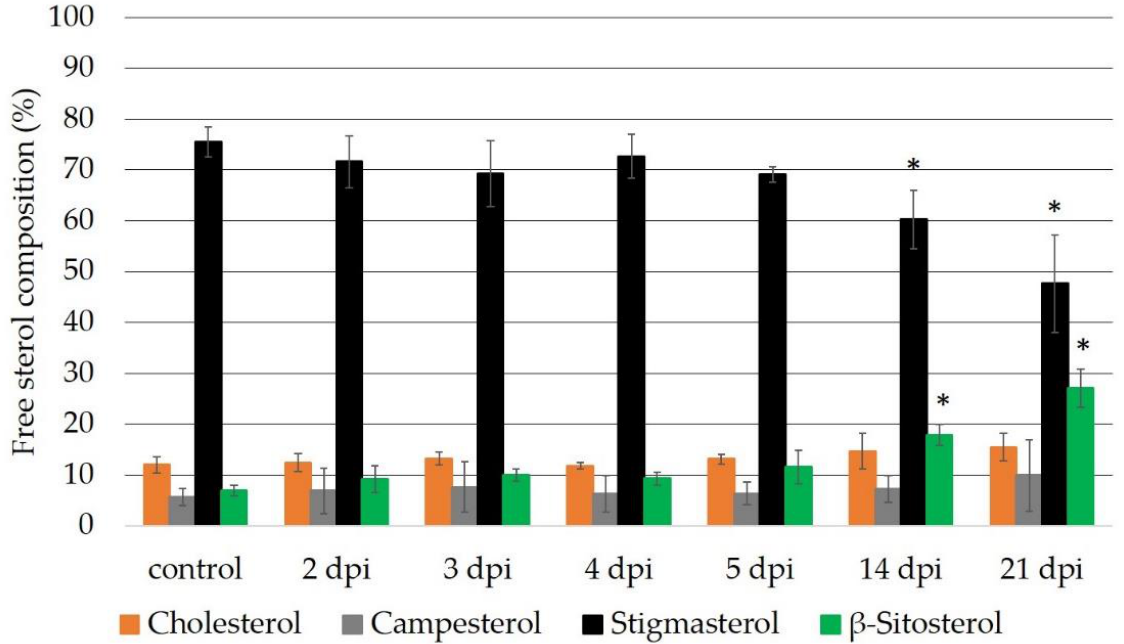
Figure 3. Gas chromatography–mass spectrometry analysis of the composition of the free sterols in the uninfected tomato cv. Moneymaker roots (control) and at 2, 3, 4, 5, 14 and 21 days post-inocula- tion with M. incognita (dpi), respectively. n = 4 biological replicates of 2 pooled plants per analysis. ANOVA was used for comparisons of the time and sterol alterations. *, significantly different from the control at p < 0.05.